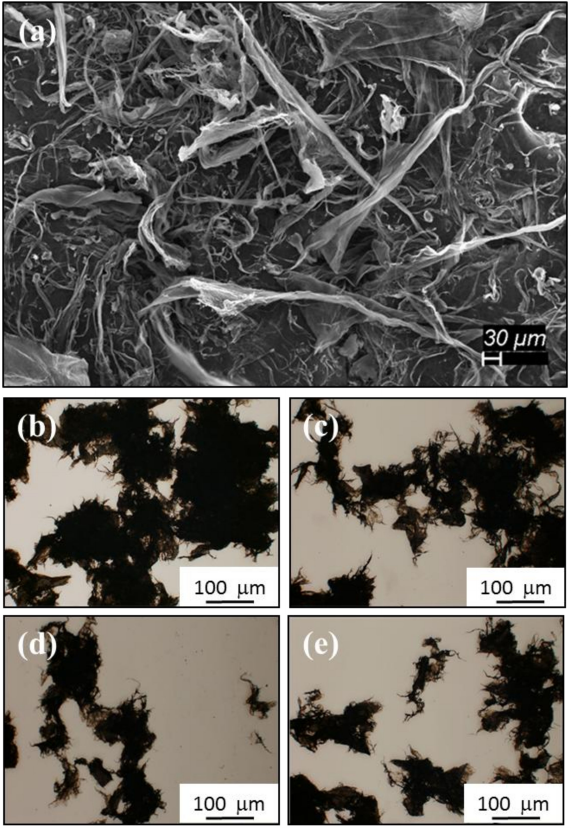
Figure 1. ( a ) Scanning electron microscopy (SEM) image of carbon nanotubes (CNT) pulp as received. ( b – e ) OM images of CNT bundles of diverse sizes generated by different cutting and grinding conditions: Grind 1,2,3, and 4